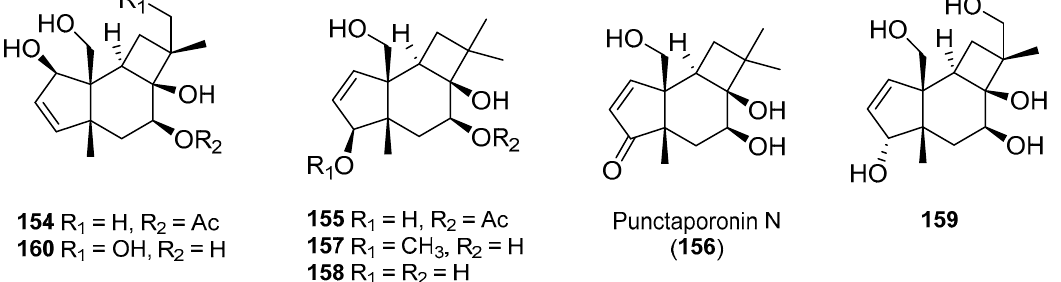
Figure 24. Structures of punctaporonins 154 – 160 isolated from the Hansfordia and Pestalotiopsis genera of fungi.